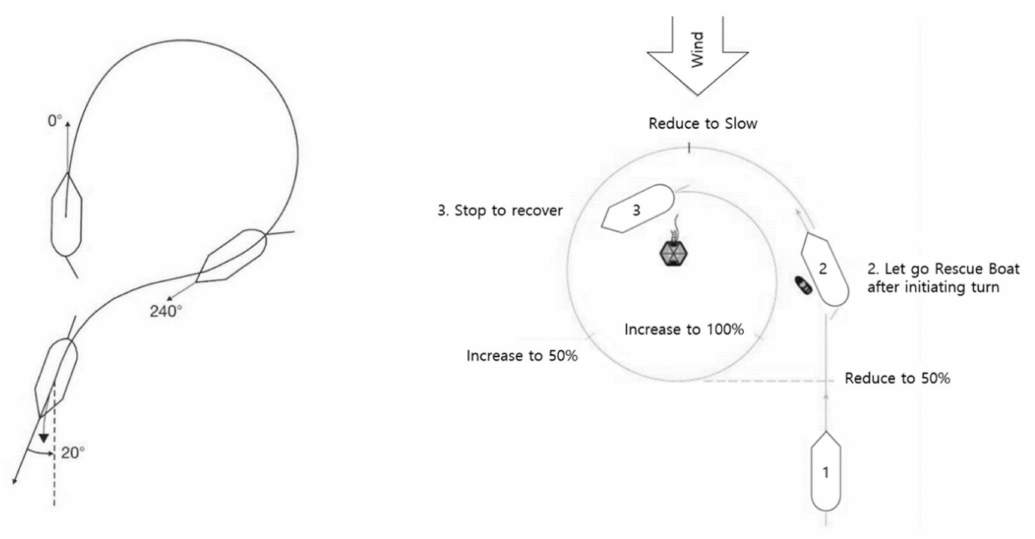
Figure 2. Scharnov turn ( left ) and Lor é n turn ( right ).